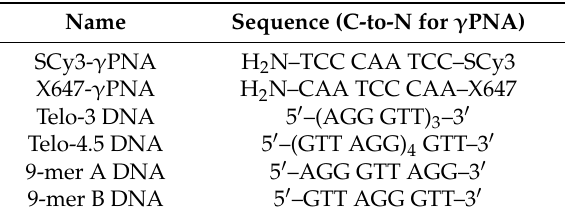
Table 1. γ PNA miniprobe and DNA oligomer sequences. Table 1. γPNA miniprobe and DNA oligomer sequences.